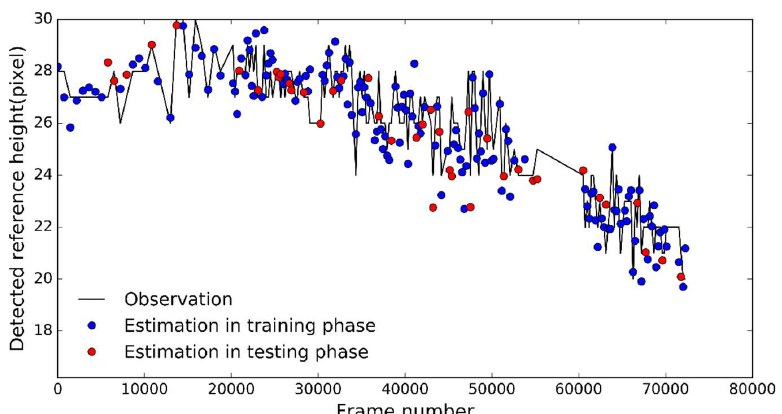
Figure 4. The height of the reference object detected by handwork (i.e., observations) and the height detected by the single shot detector (SSD) (i.e., estimations).